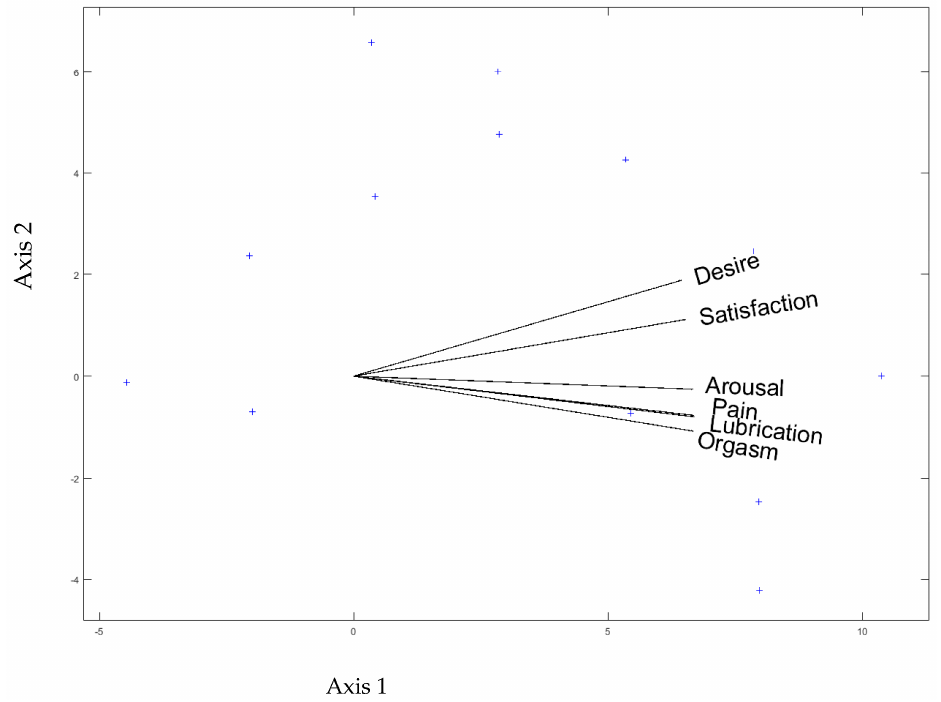
Figure 1. HJ-Biplot